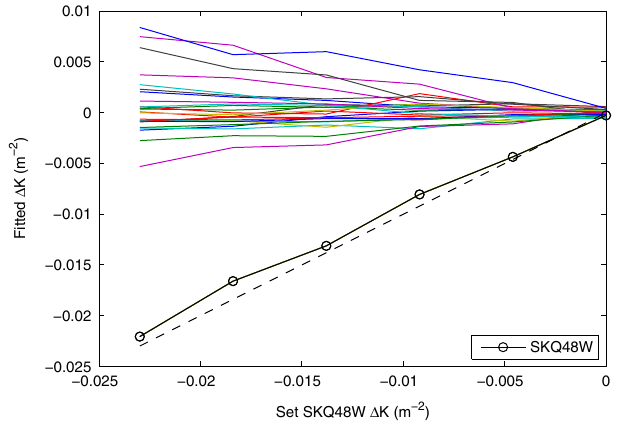
FIG. 13. Variation in skew quadrupole strengths in a model fitted to the measured mode II dispersion, over a range of applied changes in strength of skew quadrupole 48W (SKQ48W). The fitted versus applied strength of skew quadrupole 48W (black line, with data points indicated by circles) shows a linear behavior, with gradient close to 1 (shown by a dashed line). Other skew quadrupoles (colored lines) show some (approxi- mately) linear response, but with much smaller gradients.